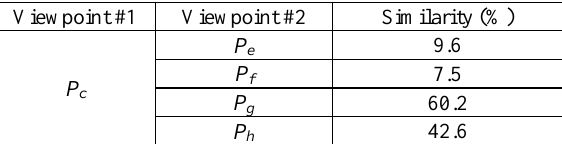
Table 2. Size Similarity between P c and plane of vewpoint